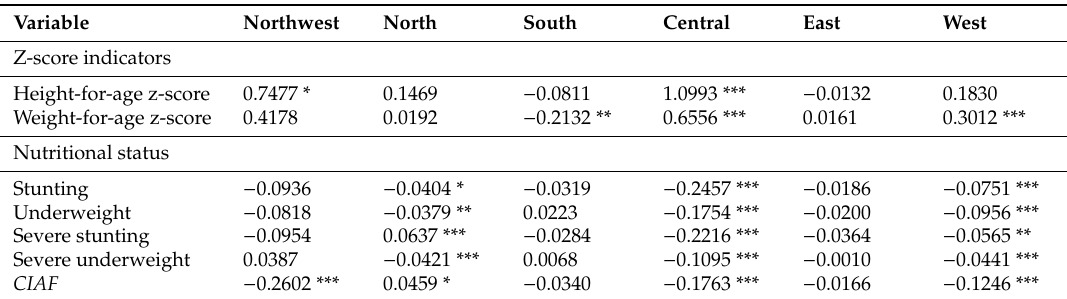
Table 2. Descriptive statistics (z-score indicators and nutritional status changes between IHDS 2004 / 2005 and 2011 / 2012).